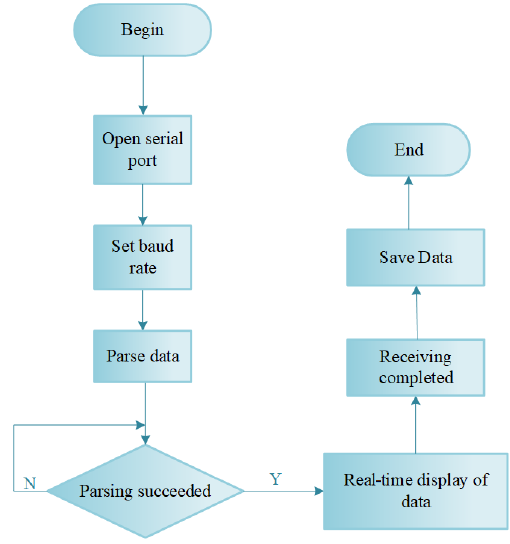
Figure 9. Workflow diagram of the upper computer.